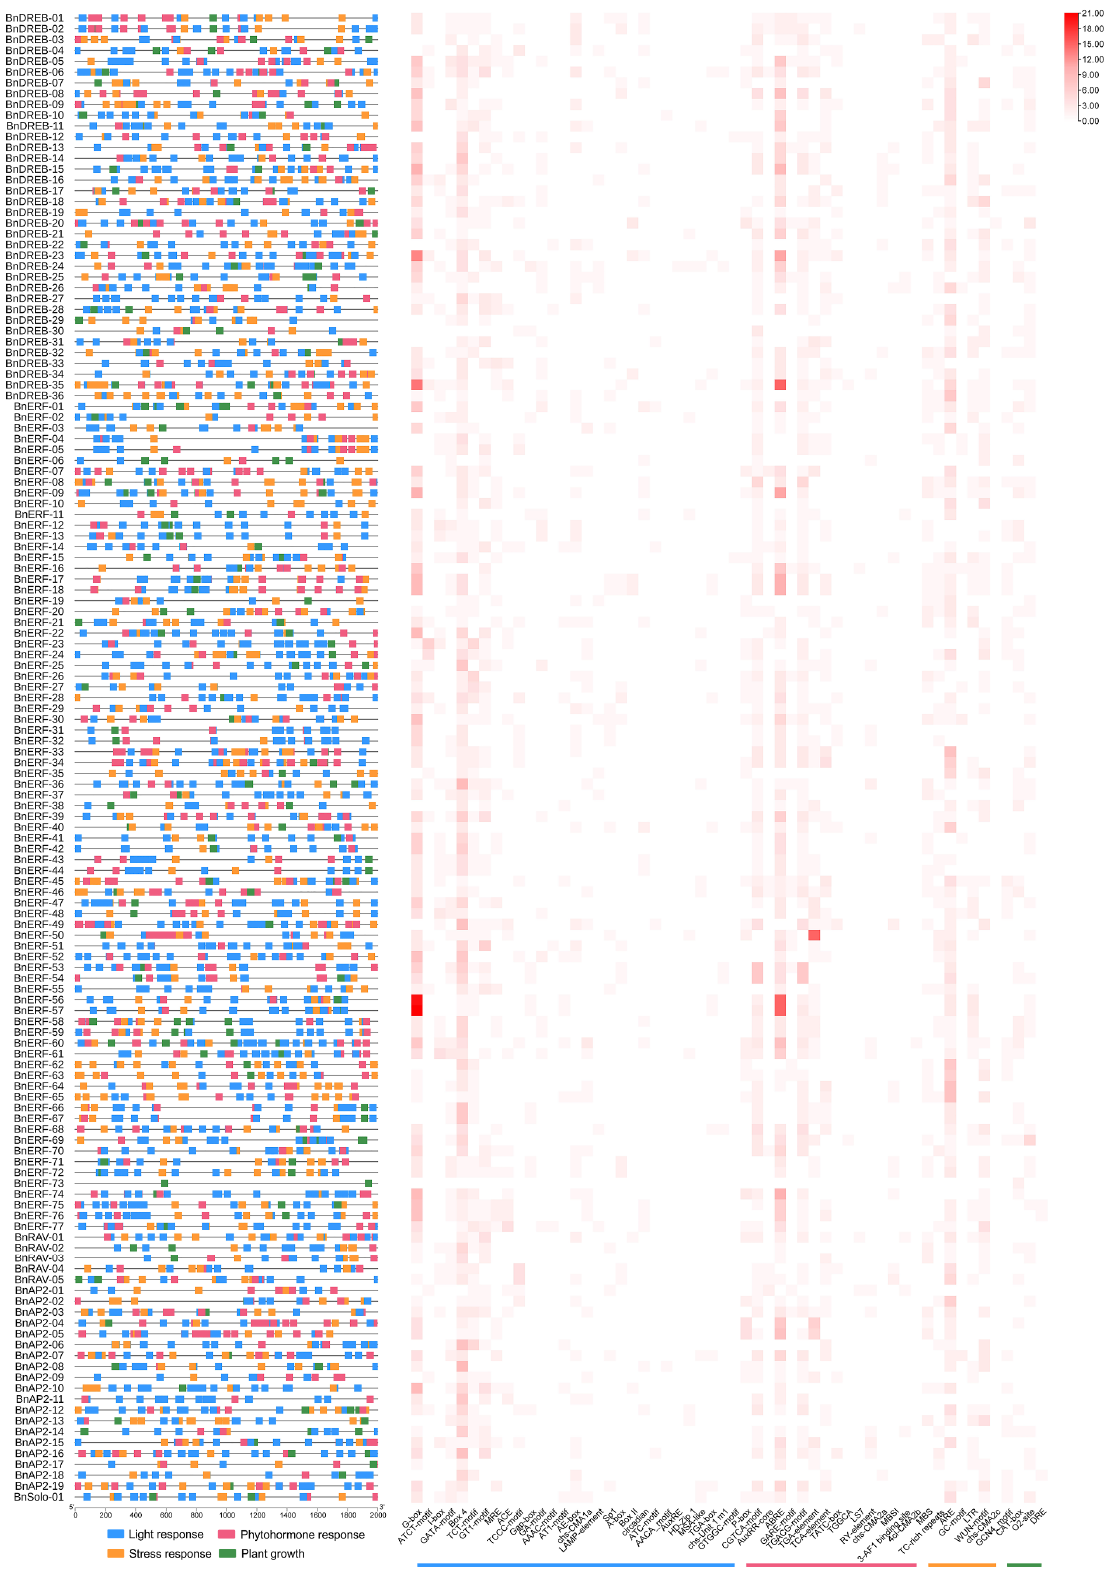
Figure 6. Analysis of cis -acting elements in the promoter region of BnAP2/ERFs . The left panel shows the distribution of cis -acting elements in the promoter region. The heat maps of cis-acting elements for the light-responsive, phytohormone-responsive, stress-responsive, and the color concentration of the squares indicates the number of cis -acting elements.